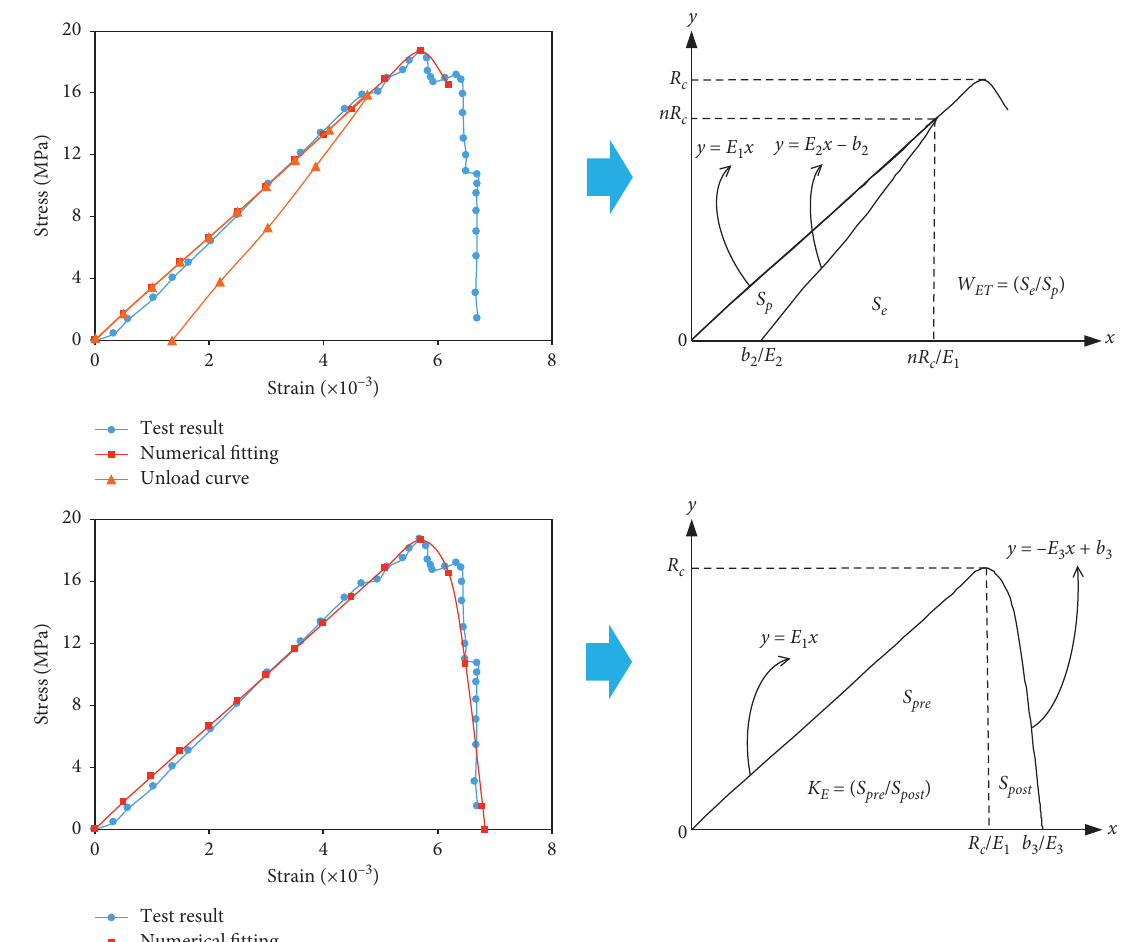
Figure 5: The functional equations of stress-strain curve before peak strength, the unload curve before 80–90% of peak strength, and the curve after peak strength for No. 12 coal